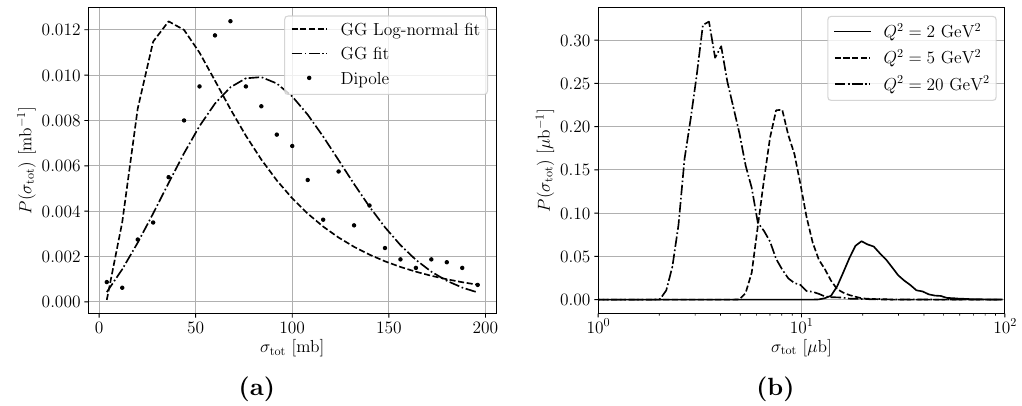
Figure 16. (a) Fluctuating cross section in pp at p s = 5 TeV, compared to a GG (cid:12)t (eq. (7.12)) and a log-normal (cid:12)t (eq. (B.2)). (b) Fluctuating cross section in (cid:13) (cid:3) p at W 2 = 5000 GeV 2 and various Q 2 , calculated with the dipole model (the double peak structure for Q 2 = 20 GeV 2 is a statistical (cid:13)uctuation). The cross section is shown on a logarithmic horizontal axis, to assess the log-normal approximation (cf. eq.